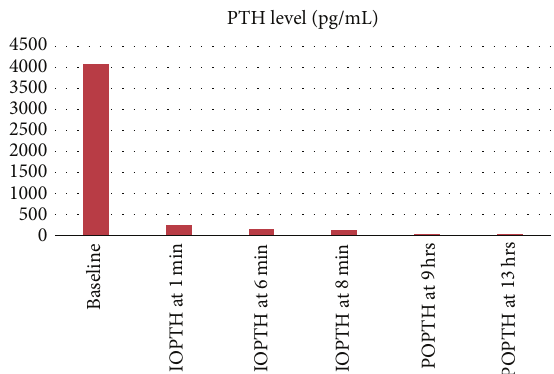
Figure 3: Radionuclide parathyroid imaging using technetium Tc- 99m sestamibi showingslow washout in the right mid thyroid region (denoted by arrow).